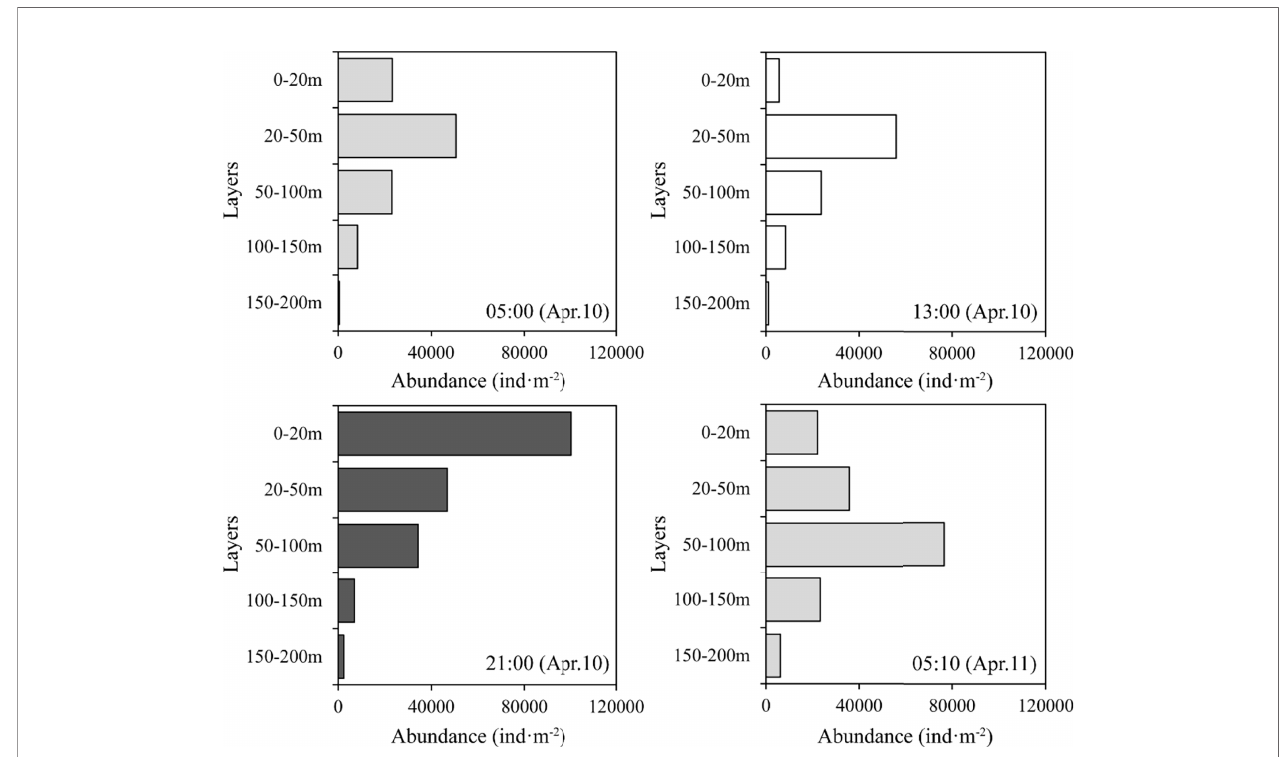
FIGURE 3 | Diel vertical distribution of total zooplankton abundance. (gray: dawn; white: daytime; black: